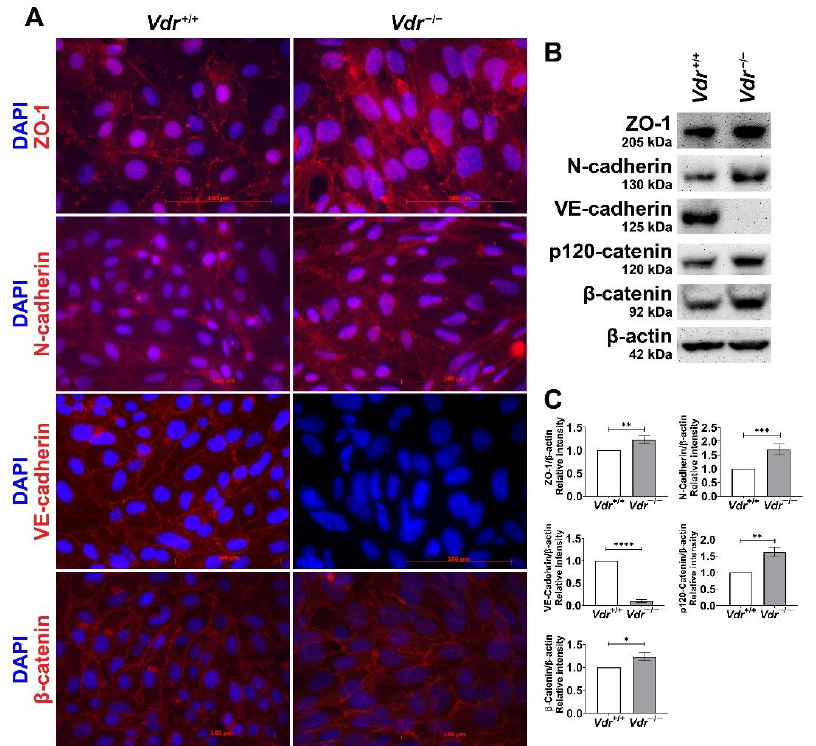
Figure 2. Cellular localization and expression levels of ZO-1, N-cadherin, VE-cadherin, p120- catenin, and β -catenin. ( A ) Retinal EC were cultured on fibronectin-coated chamber slides to confluence and stained with specific antibodies as described in Materials and Methods. ( B , C ) Western blot analysis of junctional proteins (n = 3 – 4, * p < 0.05, ** p < 0.01, *** p < 0.001, **** p < 0.0001).